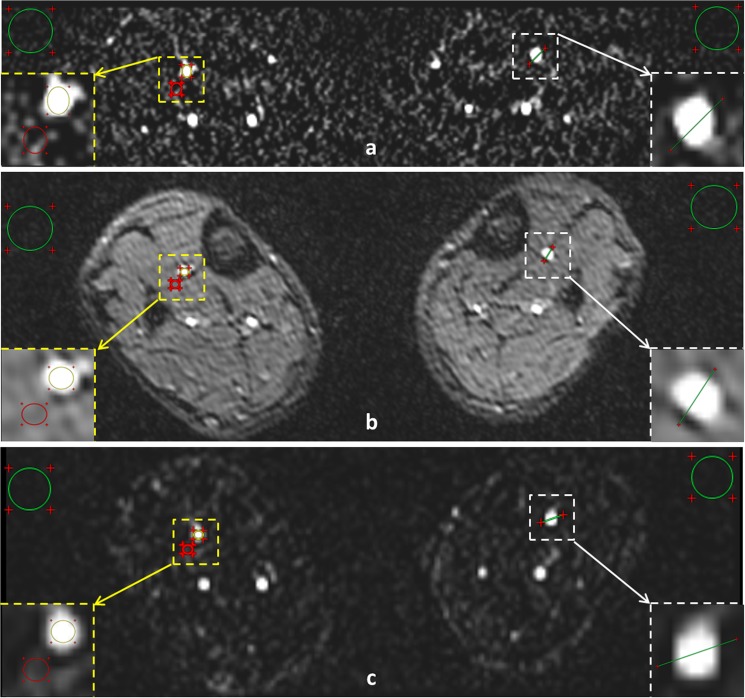
An example image including FSD (a), QISS (b), and CE-MRA (c) from which the SNR, CNR, and vessel sharpness were derived.The circles drawn in the cross-section of arterial segments (yellow circles) and the adjacent tissue (red circles) indicated the representative ROIs for the calculation of signal intensity of arterial blood and tissue, respectively. The circles drawn in the background (green circles) indicated the representative large air ROI for the calculation of noise. The line drawn perpendicularly to the vessel wall indicated the representative user-selected line for the calculation of vessel sharpness.